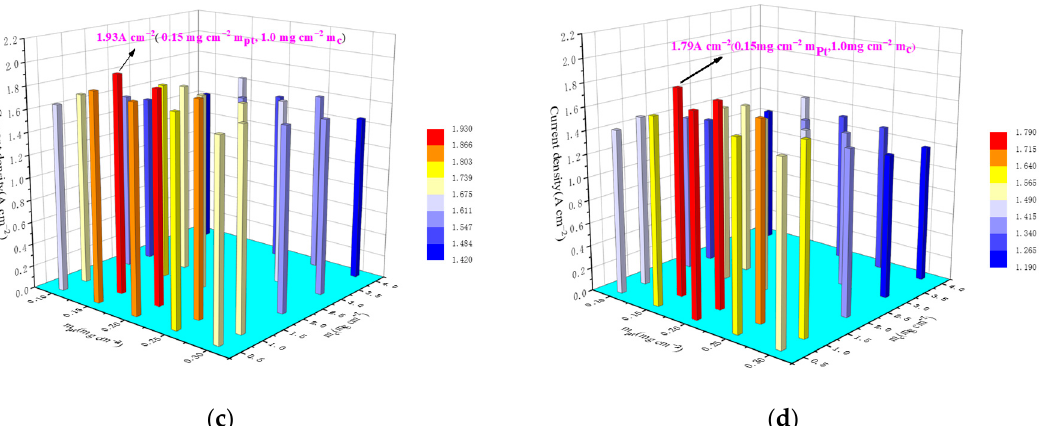
Figure 14. Performance comparison of catalyst with ( a ) Nafion volume fraction of 0.10, ( b ) Nafion volume fraction of 0.15, ( c ) Nafion volume fraction of 0.20, and ( d ) Nafion volume fraction of 0.25.